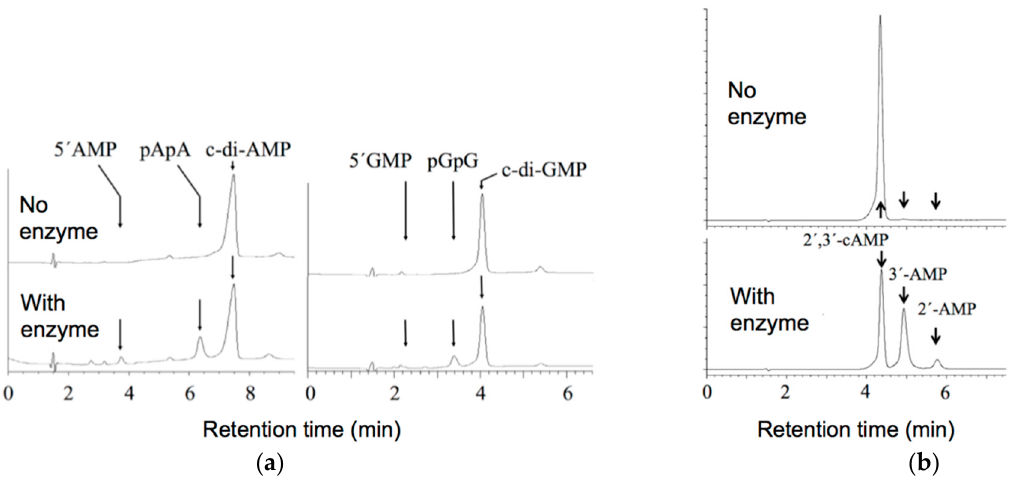
Figure 3. Products of the hydrolysis of cyclic (di)nucleotides by CpdB_Ndom. ( a ) Hydrolysis of c-di-AMP or c-di-GMP at 20 µM concentration of the dinucleotide. ( b ) Hydrolysis of 2 ′ ,3 ′ -cAMP at 500 µM. The traces were recorded at 260 nm. Arrows indicate the retention times of the standard compounds. pGpG, 5´-phosphoguanylyl-3´ → 5´-guanosine.